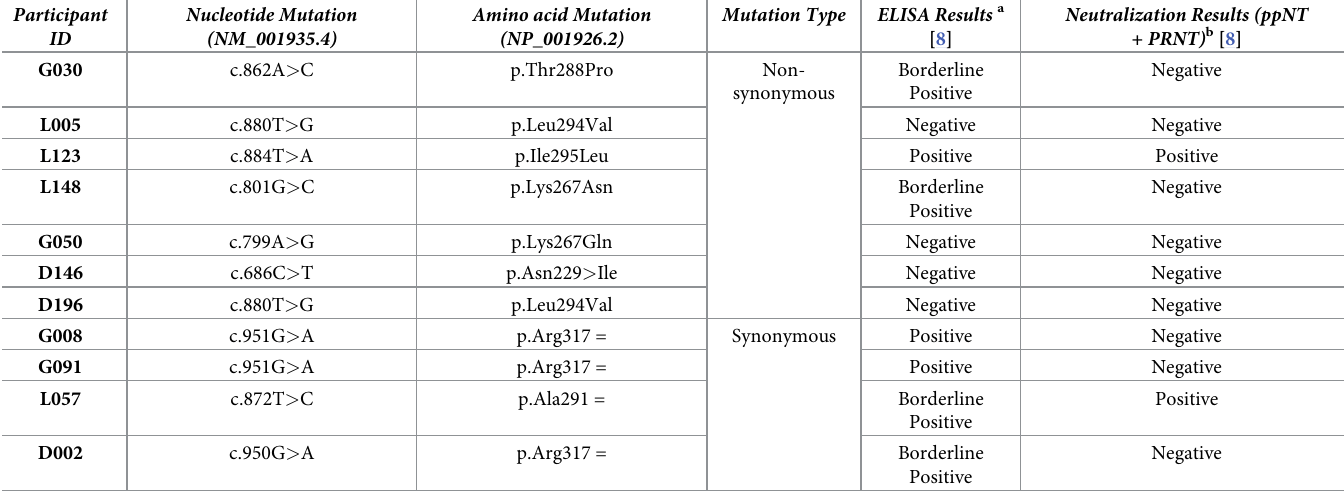
Table 3. Participants serological profile with identified mutations in amino acid residues engaging the interaction of DPP4 with MERS-CoV.